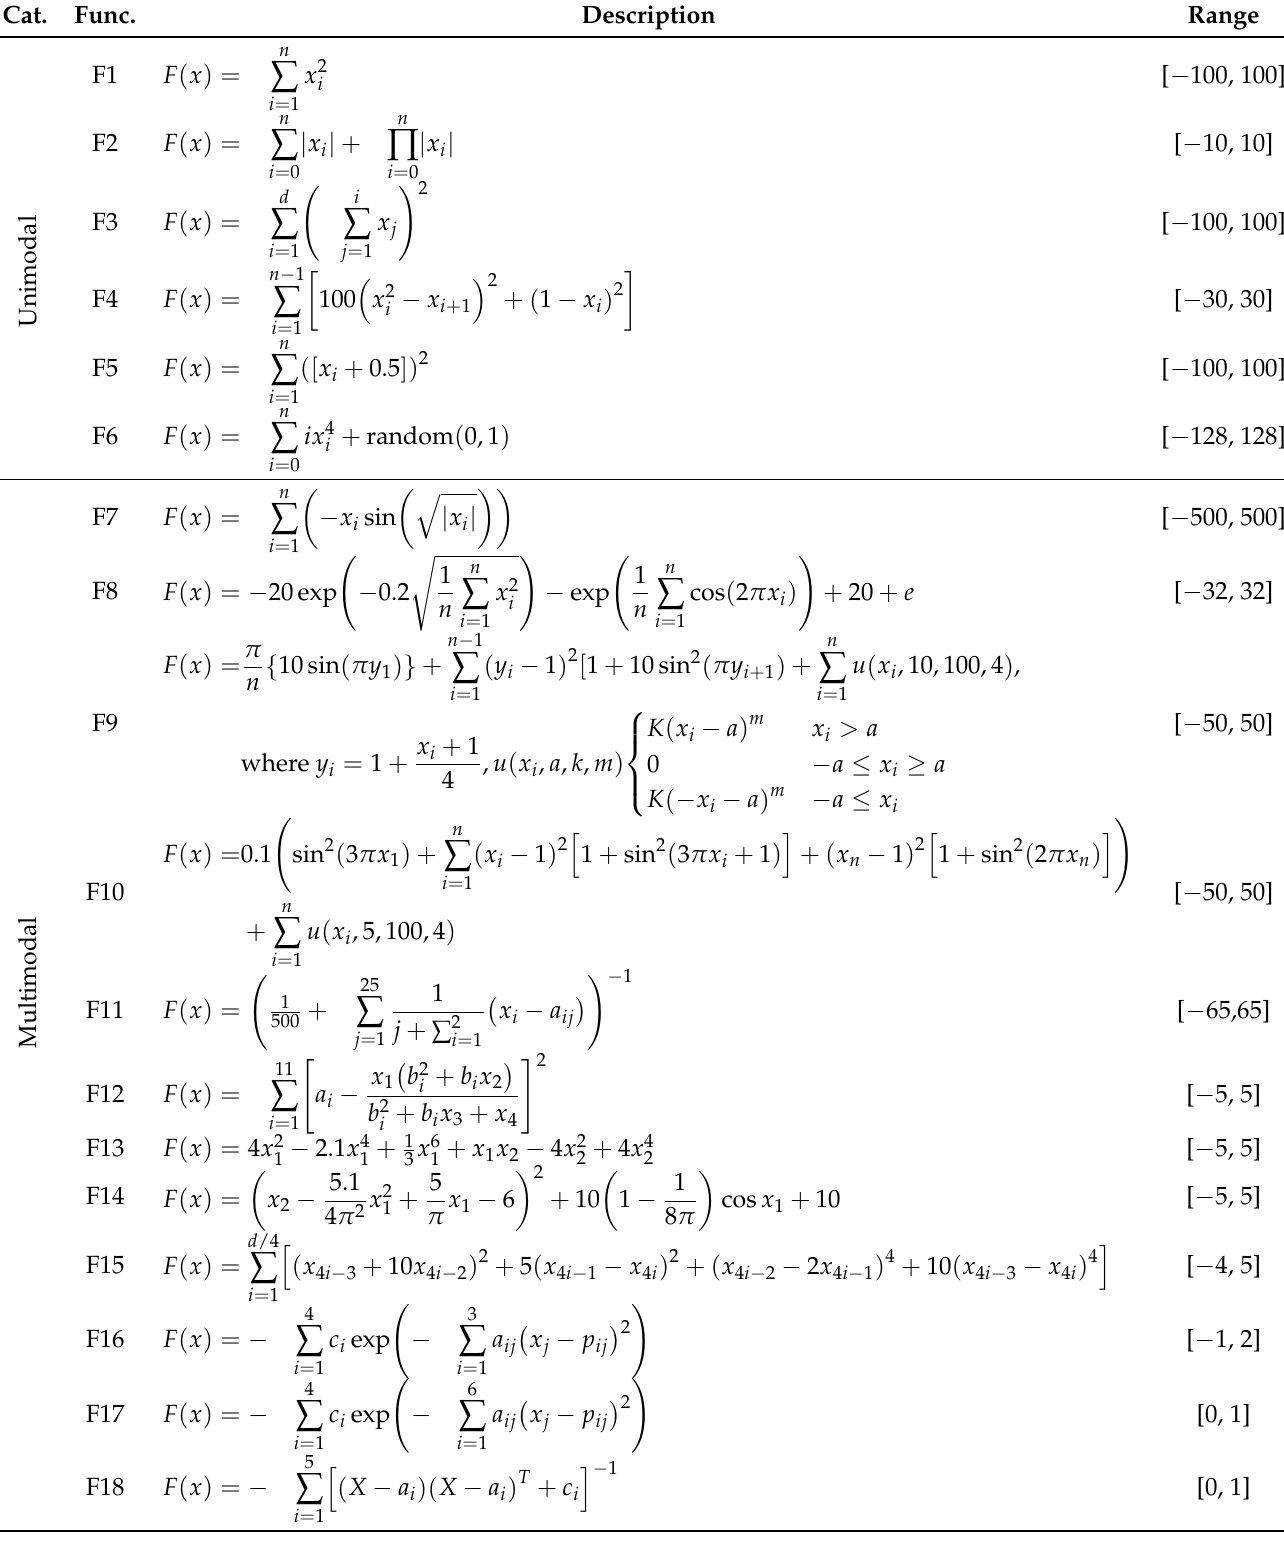
Table 2. Considered benchmark functions for the performance analysis.